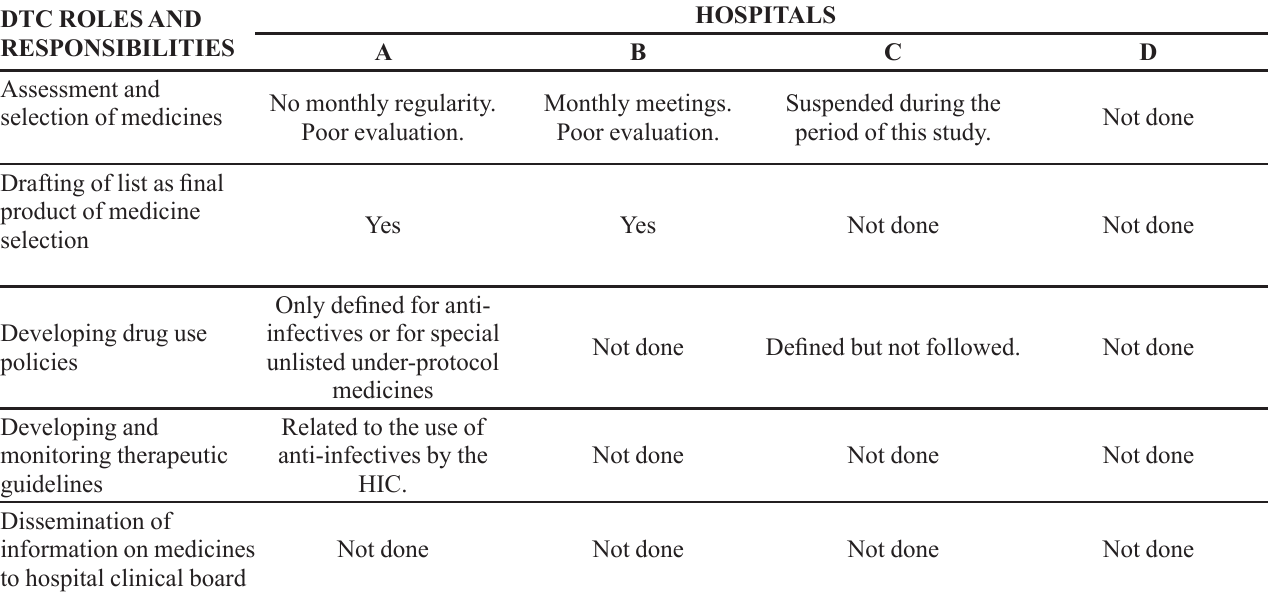
TABLE IV - Functions related to medicine selection in university hospitals. State of Rio de Janeiro, 2011 DTC ROLES